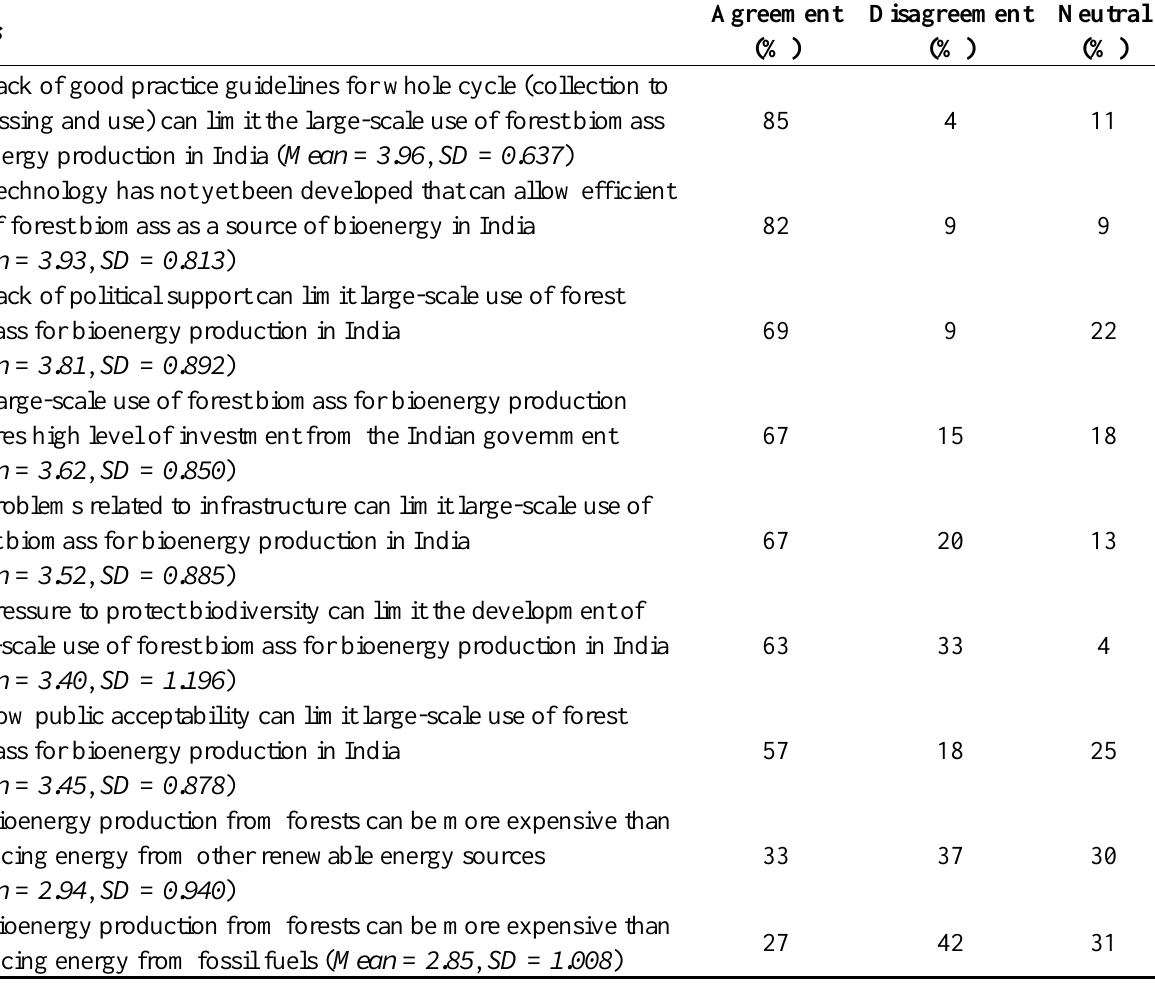
Table 4. Respondents’ perceptions of the potential challenges of forest-based bioenergy (FBE) projects in India ( N =